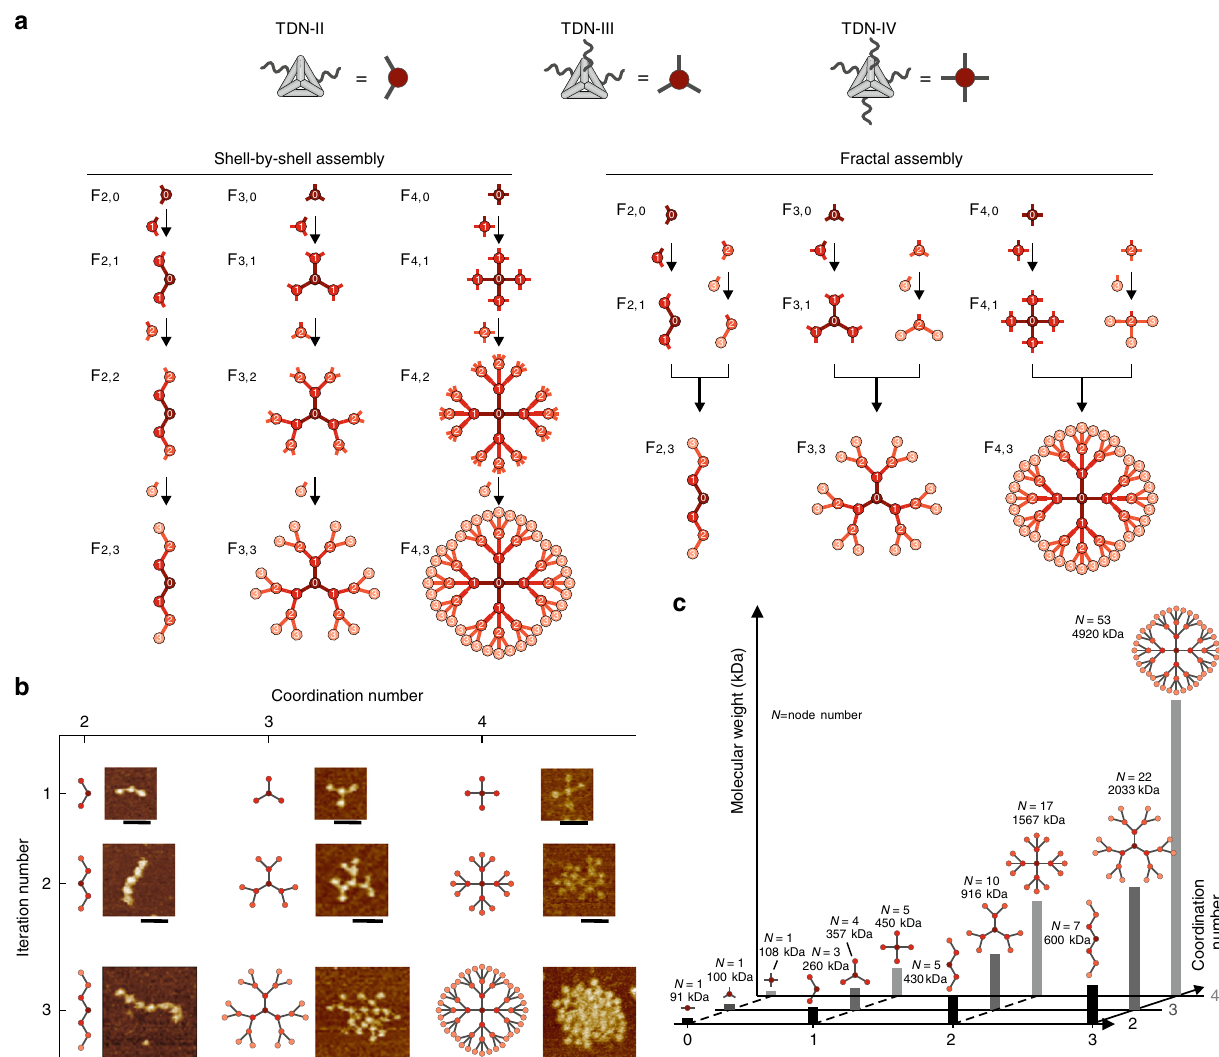
Fig. 1 Fractal DNA frameworks (FDFs) with precise node numbers and molecular weights. a Schematic of FDFs ’ assembly strategies. b Representative AFM images of the FDFs. Scale Bar, 50 nm. c Comparison diagram of FDFs with different node numbers ( N ) and molecular